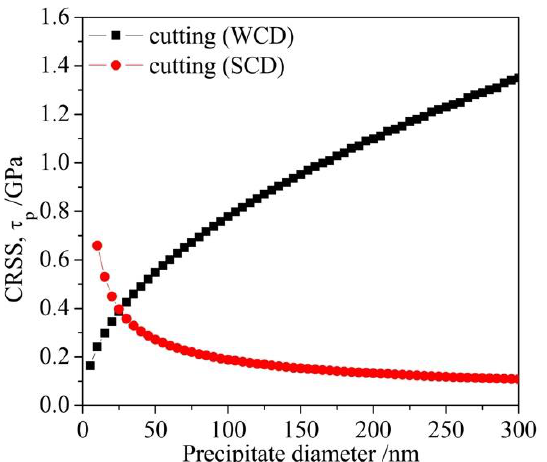
Figure 10. Analytical calculations of critical resolved shear stress (CRSS) vs. precipitate diameter including weakly coupled dislocation (WCD) model and the strongly coupled dislocation (SCD) model.